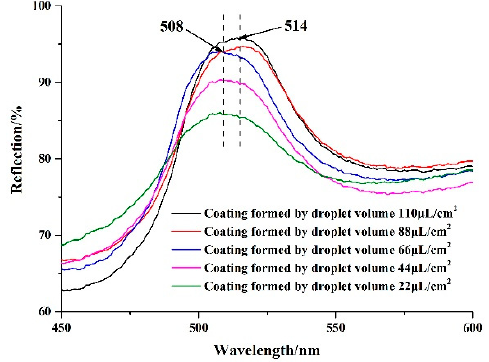
Figure 11. UV-Vis spectra of the coatings formed by different droplet amounts.